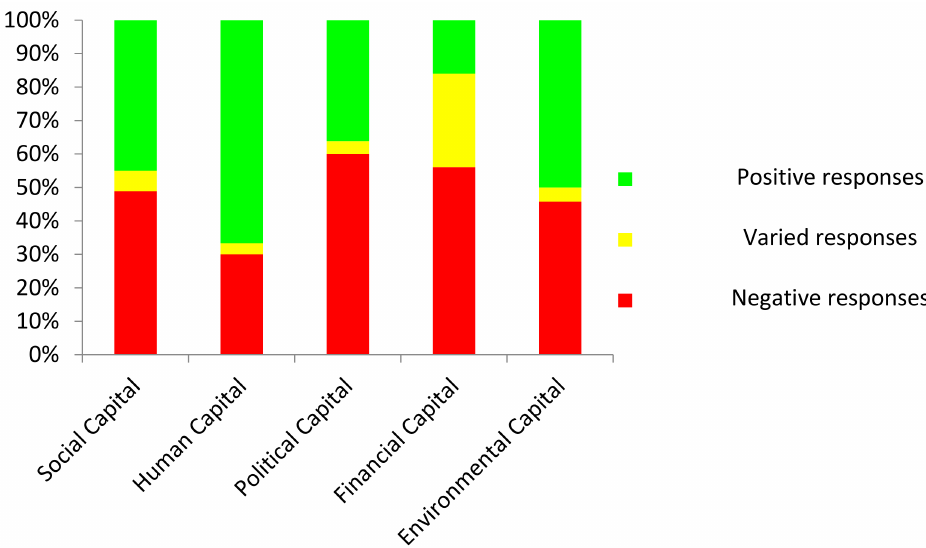
Figure 2. Results from the assessment of five capitals of local governance for water management in Quarry Road West informal settlement, Durban South Africa. Strength of each capital, with positive responses in green, varied in yellow and negative responses in